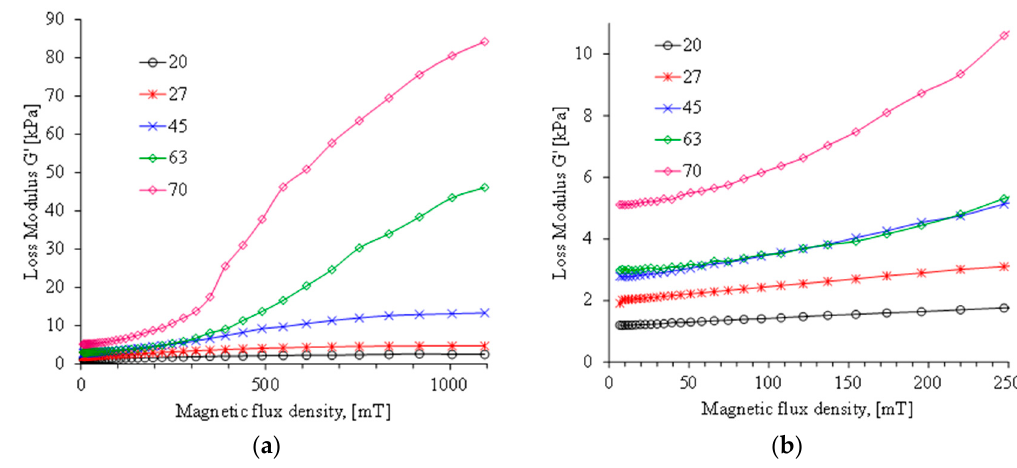
Figure 16. ( a ) Loss modulus behavior for the MRE material samples with 20, 27, 45, 63, and 70 wt % under the action of a variable magnetic flux density from 0 to 1093 mT. ( b ) Detailed view of the material behavior for magnetic flux density range from 0 to 250 mT. As expected, when a magnetic field is induced on the MREs samples, the relative storage and loss MR e ff ects [10] increase with respect to those values recorded in the MREs samples without magnetic field, as shown in Figure 17. Notice a significant change in the relative MR e ff ects of the complex modulus in the sample with 70 wt % of magnetic